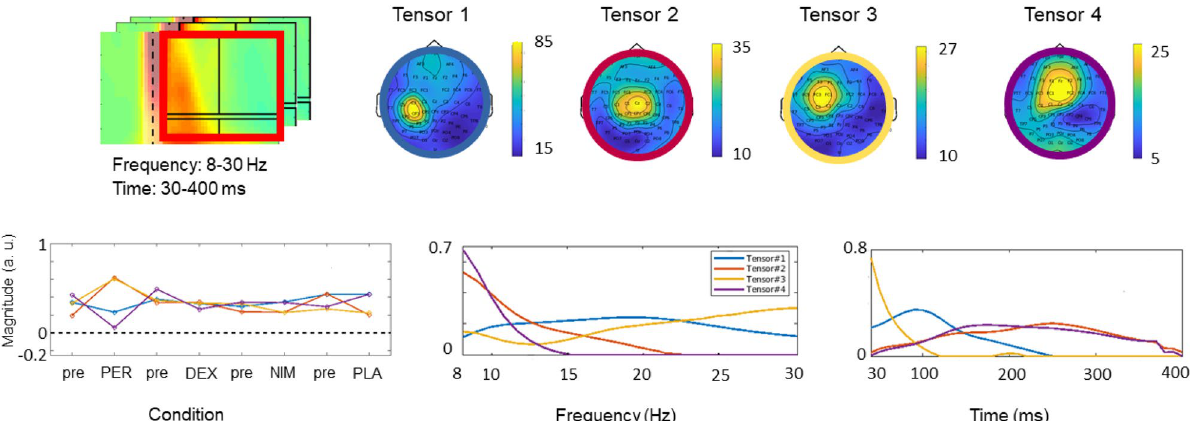
Figure 6. PARAFAC tensor decomposition of TMS-induced EEG oscillations (TIOs). Top row shows in the red square the time–frequency representation window employed for tensor decomposition analysis (the black lines denote the time–frequency intervals of the standard TIO analysis), and the topographies of the four tensor components (TCs) obtained from the induced data circled with four colors: blue, red, yellow and violet. The four TCs we obtained by extracting the most relevant components out of a 5D tensor with dimensions: Subject, Space, Drug Condition, Frequency, and Time. Bottom row, left plot: Drug-induced changes of the four tensors comparing pre- and post-drug data (PER, perampanel; DEX, dextromethorphan; NIM, nimodipine; PLA, placebo; the same colors as in top row indicate the different tensor components). Central plot: tensor frequency contents. Right plot: tensor time courses (time after the TMS pulse, in ms). Figure generated with MATLAB R2016a (https:// www. mathw orks. com) and the Fieldtrip Matlab toolbox (http:// www. field tript oolbox.